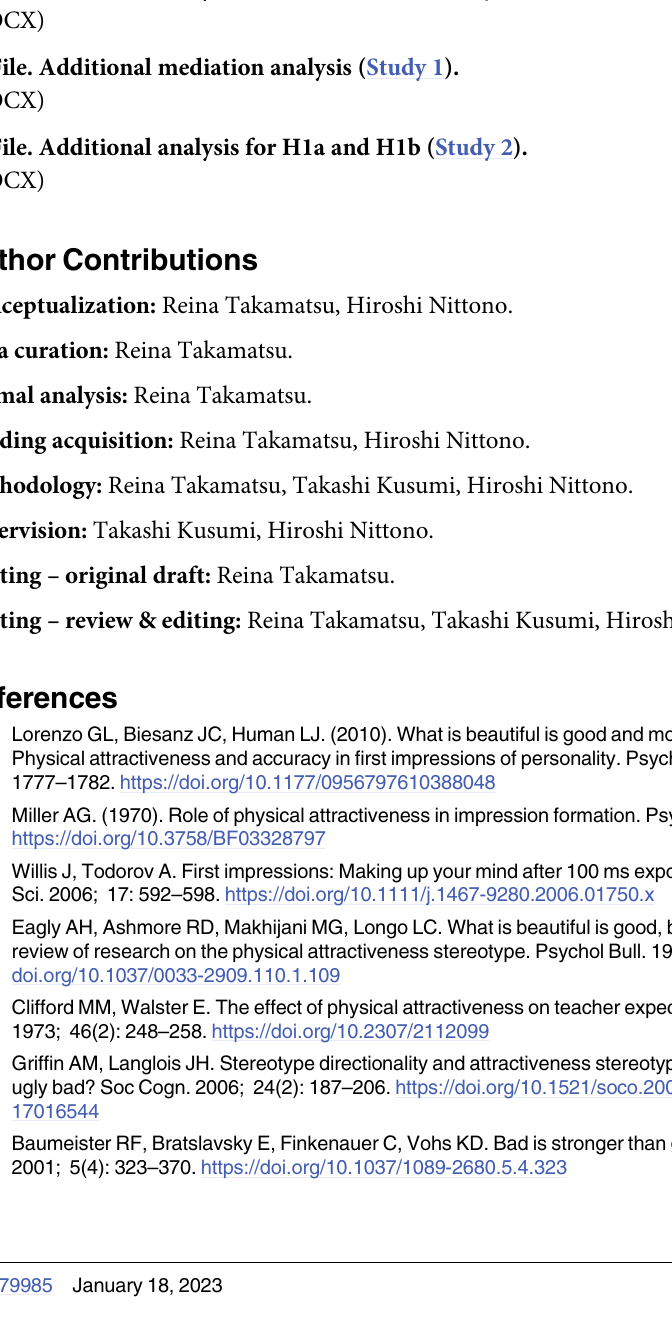
S1 Table. Partial correlations among variables in the mediation